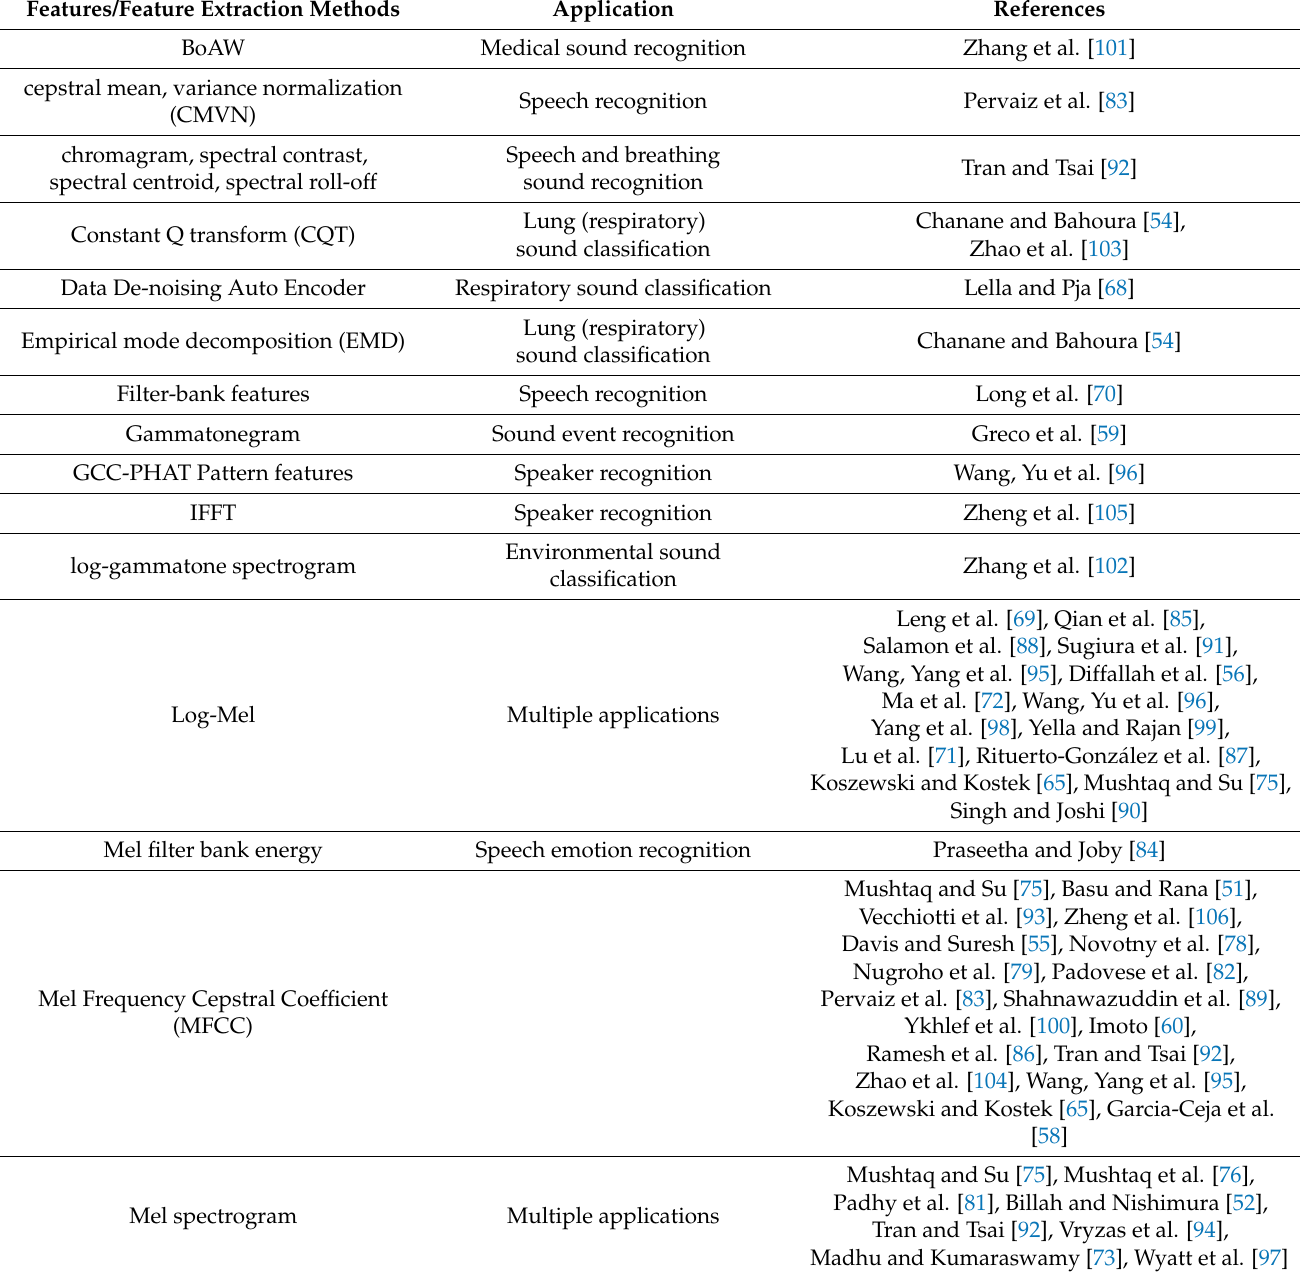
Table 3. Summary of feature extraction